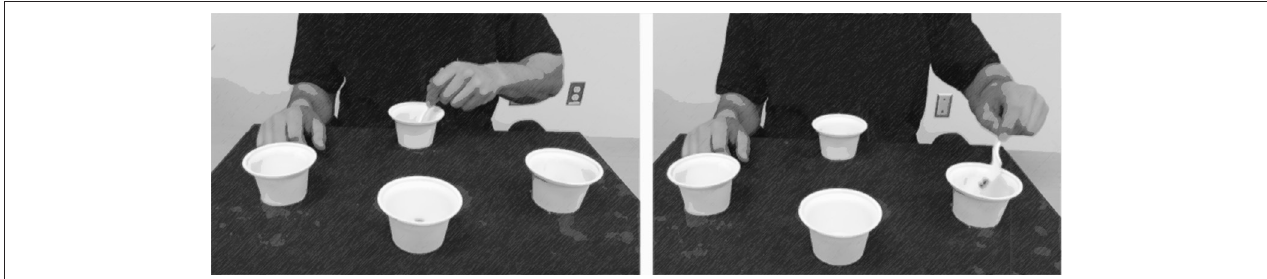
FIGURE 1 | Participants used their non-dominant hand to complete a reaching task that simulates feeding oneself; participants use a spoon to select only two beans from the center “home” cup and deposit them into target cups. One trial consisted of 15 repetitions (i.e., five arcs to each of the three target cups). This figure was adapted from “Dexterity and Reaching Motor Tasks” by MRL Laboratory is licensed under CC BY